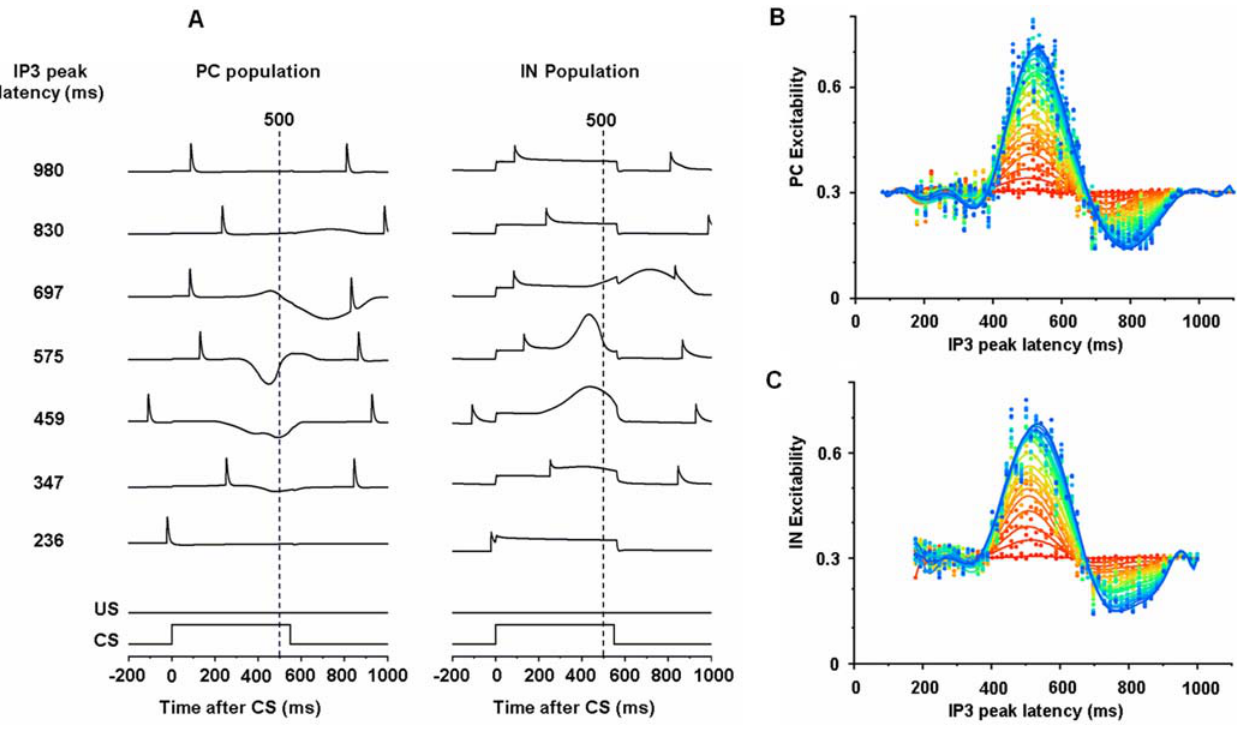
Figure 7. Learned increased excitability of PCs and INs. A. Each row shows responses of a pair of a PC and an attached IN to the CS during a test trial (no US is given; see US, and CS signals at the bottom of each column). Every eighth PC-IN pair among 54 modules is displayed. Learning was induced by CF-PF couplings with an ISI of 500 ms. While PCs and INs show responses to the PF input, the modulations are noticeable only in the pairs having IP3 peak latencies (left column) around 500 ms (three middle traces). The narrow peaks are CF-induced activations. The broken lines indicate the time when the US is delivered (500 ms after the CS) in pairing trials. Panels B and C show the concurrent development of learned long-time scale excitabilities (the dots) in PC and IN subpopulations (with IP3 peak latencies , 500 ms) that are responsible for the PC-IN interactions shown in A. Every 25 th trial is shown for clarity (red to blue is early to late). The curves in corresponding colors are polynomial fits in each learning stage. Also note the troughs (around 800 ms) after peaks (see text for explanations).